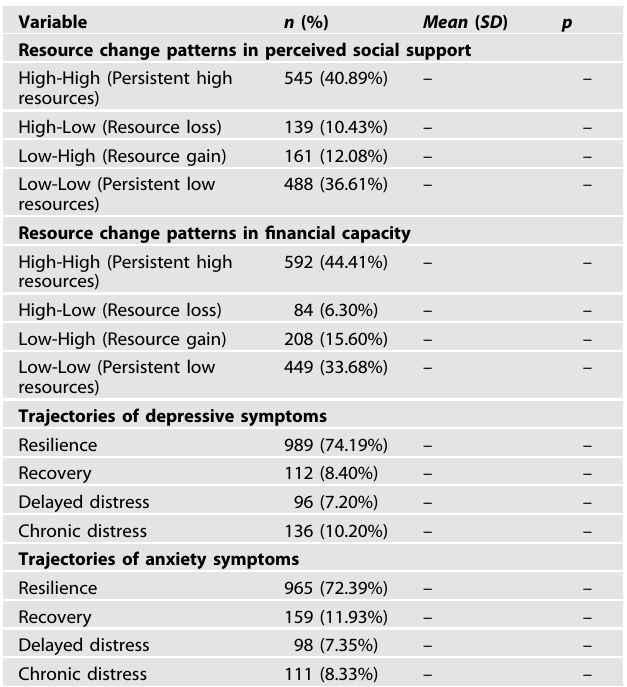
Table 1. Descriptive characteristics of the current